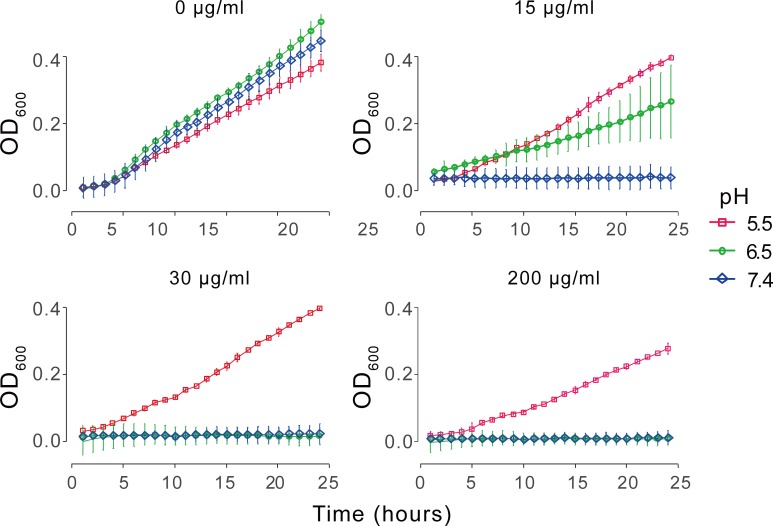
pH-dependent anti-staphylococcal activity of PE31.Representative growth curves of one strain of methicillin-resistant S. aureus (Strain No. 7) as measured by culture turbidity at 600 nm (OD600). PE31 concentration: 0 μg/mL, 15 μg/mL, 30 μg/mL, and 200 μg/mL. The data points and error bars represent mean and standard deviation of three replicates in duplicate samples per condition.